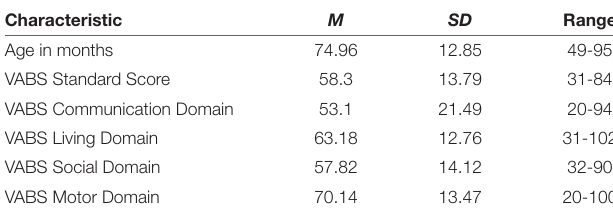
TABLE 2 | Characteristics of child